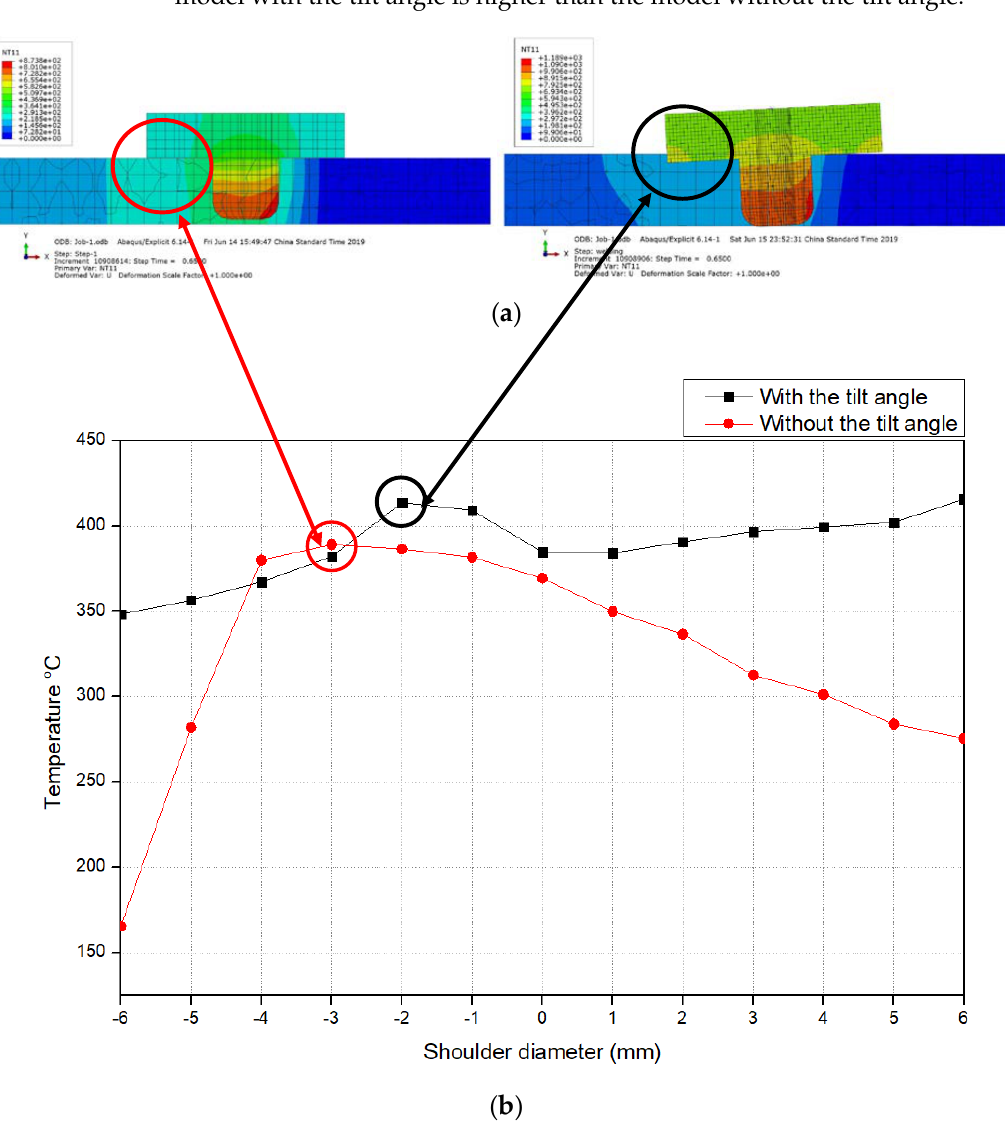
Figure 19. Temperature of the welding across the shoulder diameter ( a ) simulation results; ( b ) temperature results.